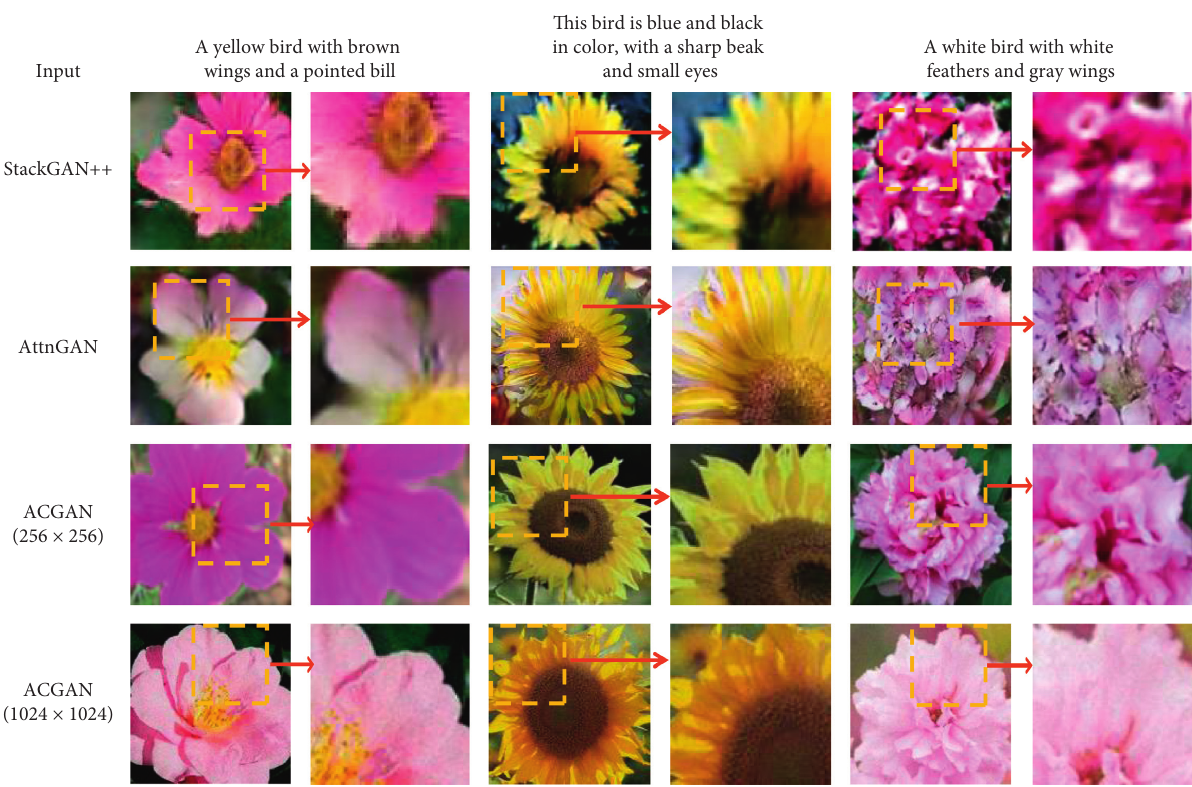
Figure 6: Details (petals) comparison of the images generated from descriptions using three GAN models trained on Oxford test